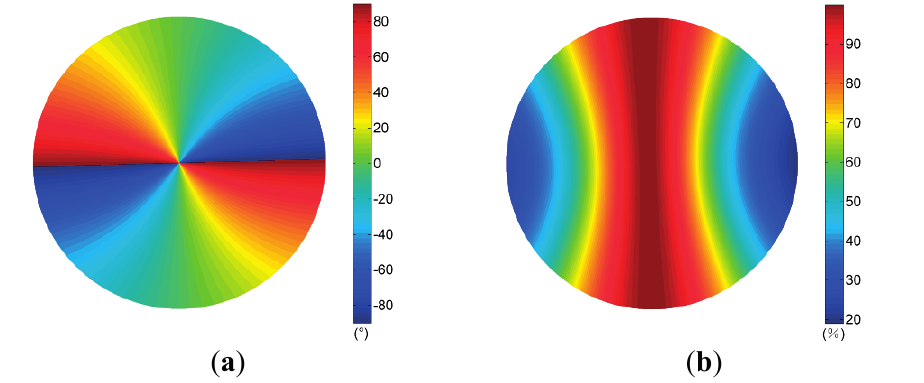
Figure 6. Patterns of skylight calculated by the single-scattering Rayleigh model (the position of the sun is the same as that in the clear sky). ( a ) AOP of Rayleigh sky; ( b ) DOP of Rayleigh